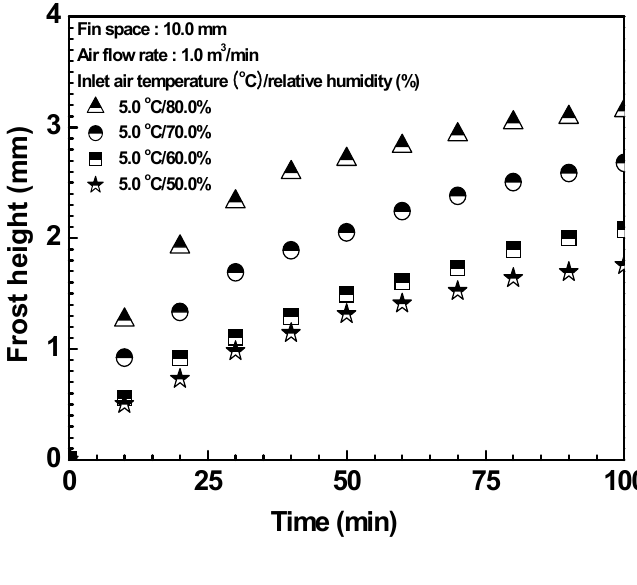
Figure 5. Frost height with the variations of the relative